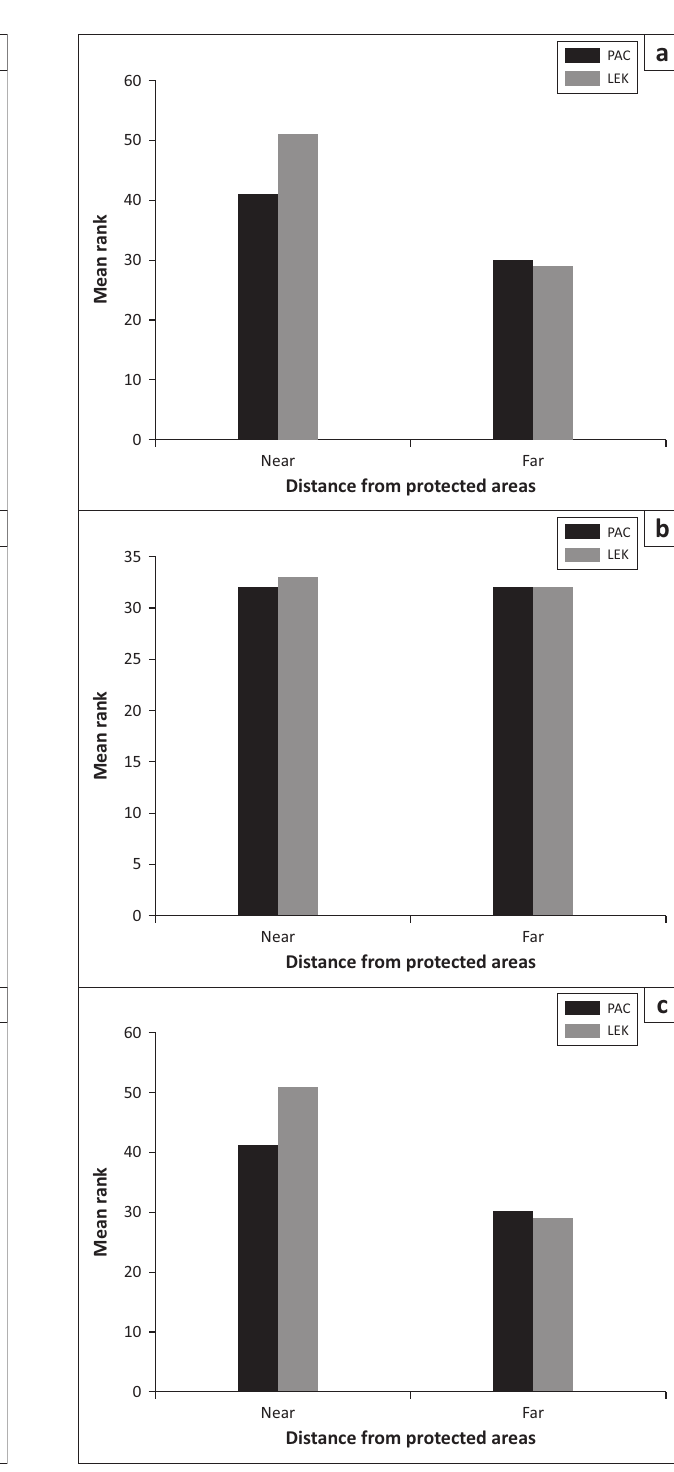
FIGURE 4: Comparison of carnivore predation in livestock risk areas between Department of Wildlife and National Parks–confirmed incidents (Problem Animal Control) and herders interviewed (local ecological knowledge). (a) Lion, (b) leopard and (c) wild